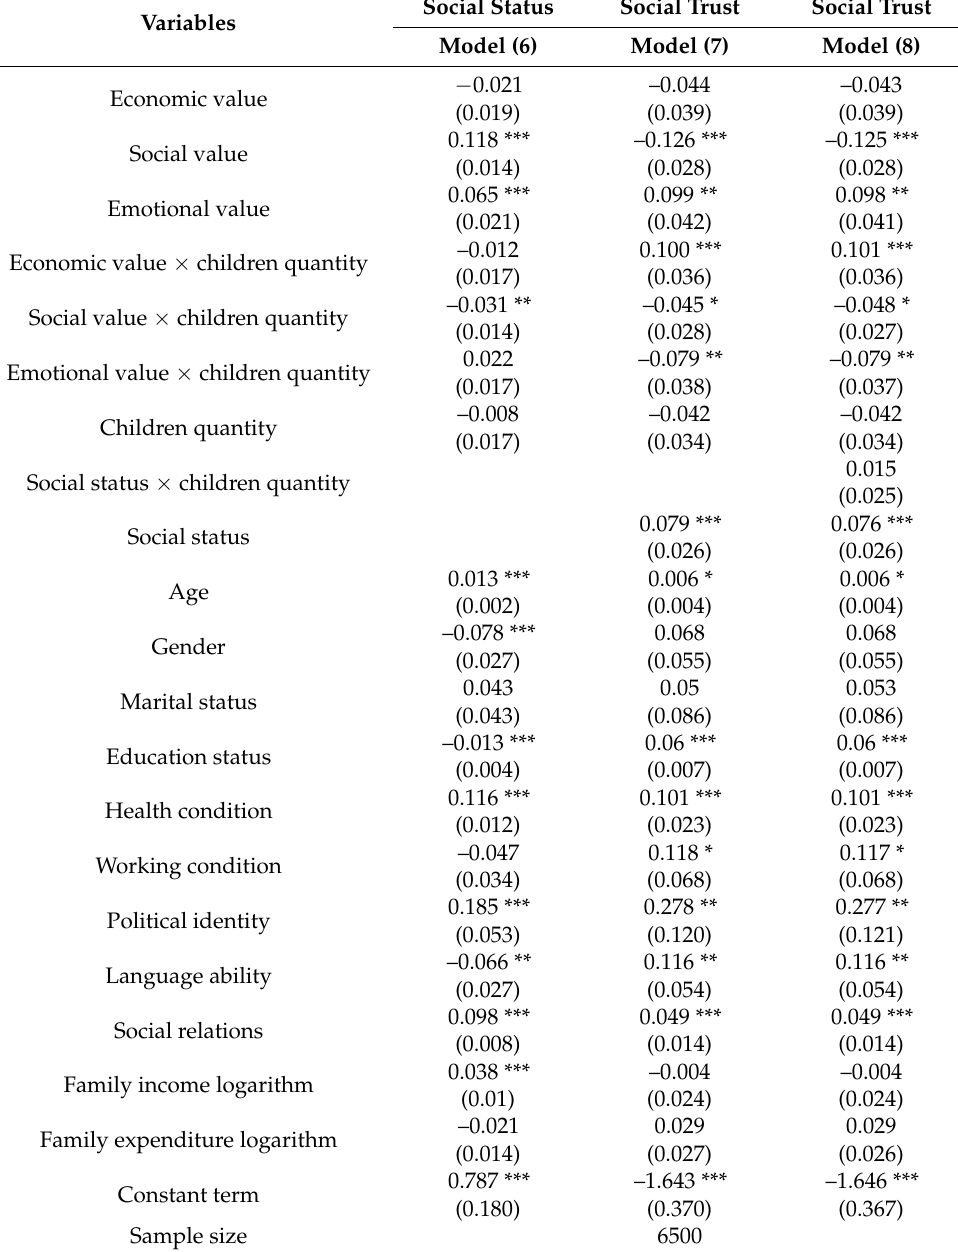
Table 5. Mixed moderation mediating effect model regression results of farmers’ children’s value influencing social